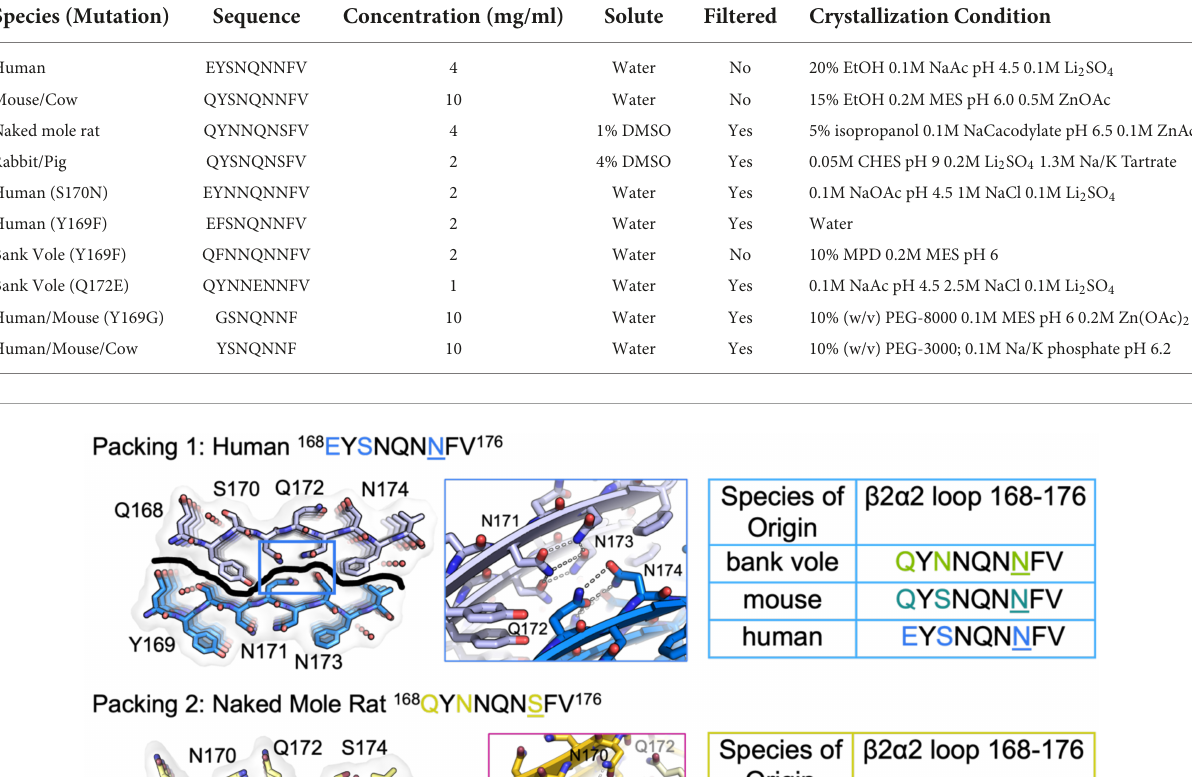
TABLE 1 Crystallization conditions for β 2 α 2 loop peptides.